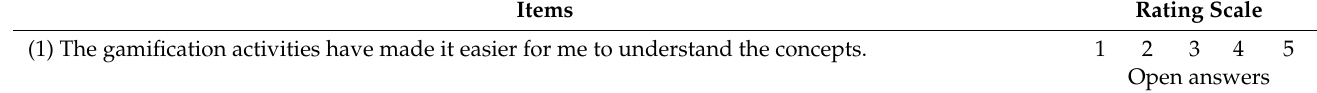
Table A3. Questionnaire of Satisfaction with the Gamification Activities (S á iz-Manzanares, 2021) [48].